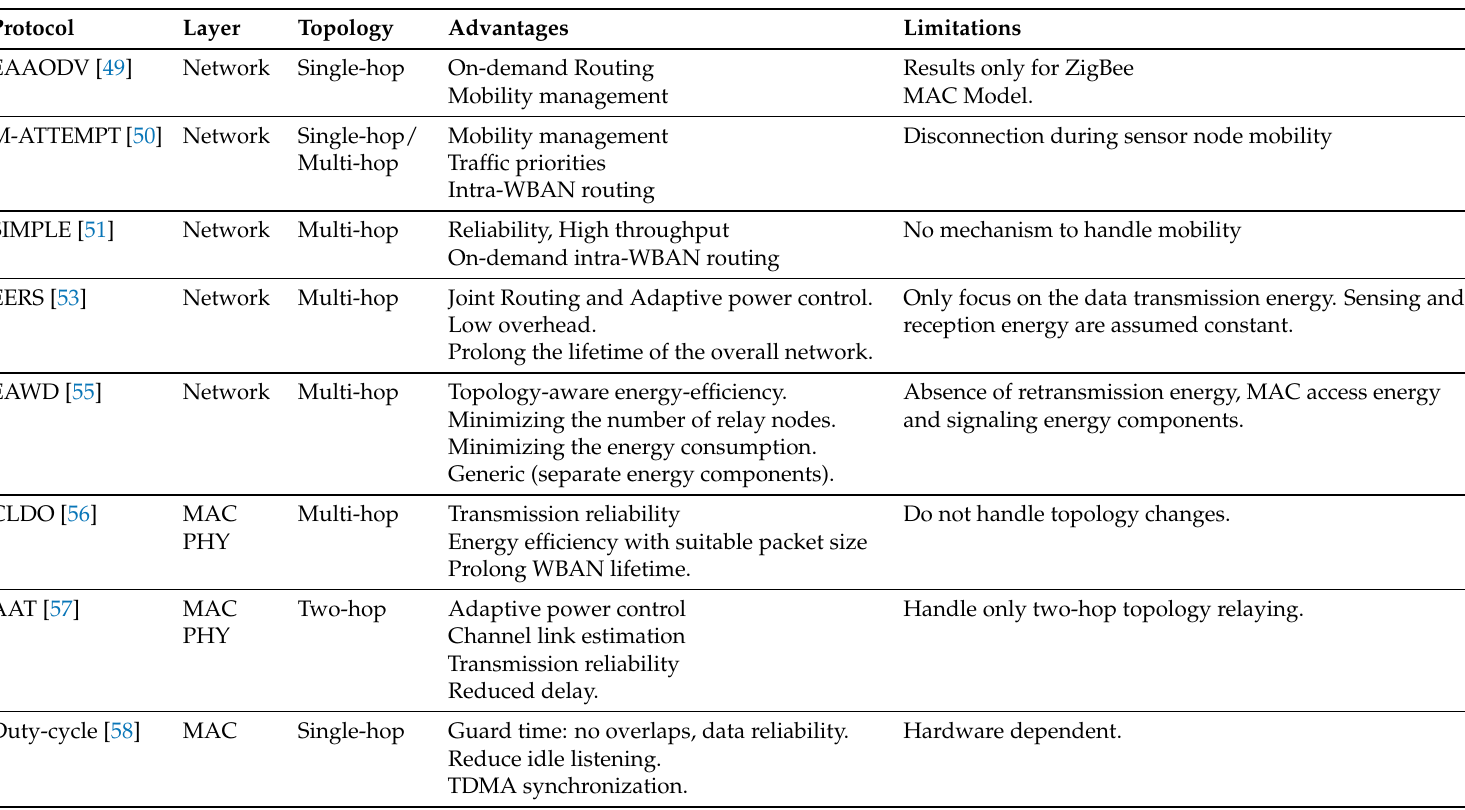
Table 1. Energy-aware candidate protocols for body-to-body networks (BBNs). c (cid:13) [2019] IEEE. Reprinted and modified, with permission, from